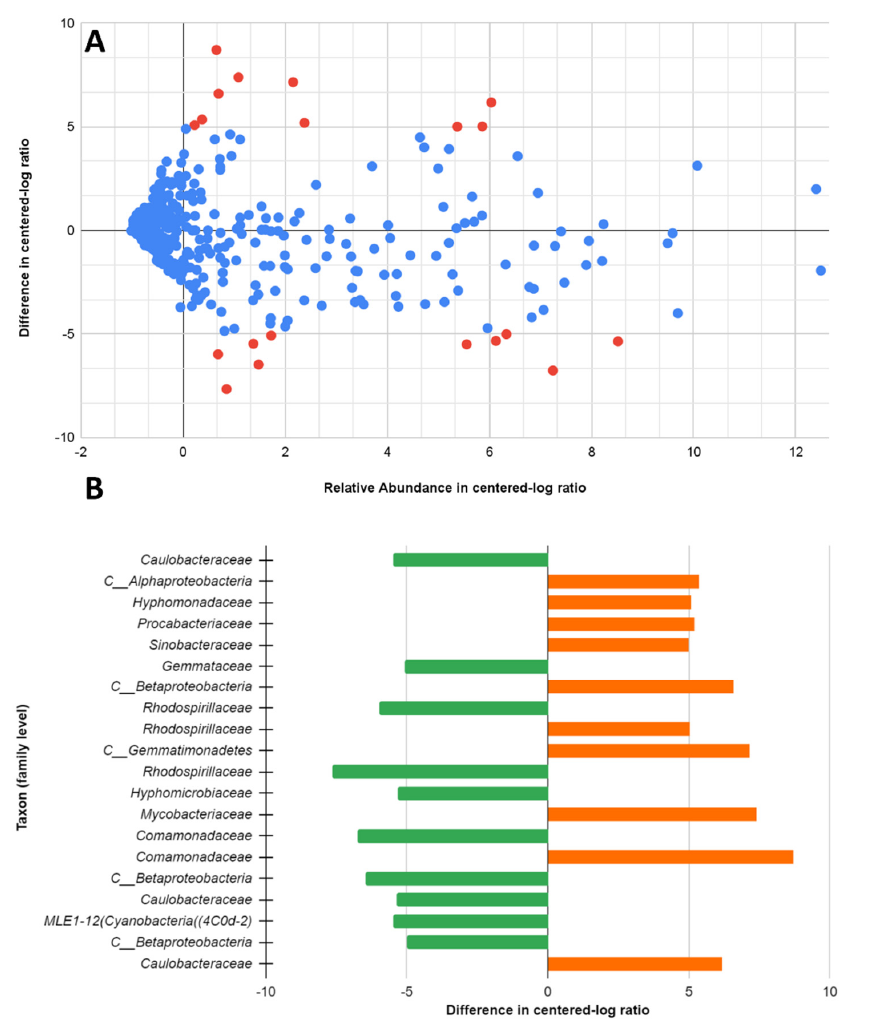
Figure 9. ALDEx2 differential abundance analysis between the 32 °C and 22 °C systems.: ( A ) Bland– Altman or MA plot between relative abundance and difference. (Significantly different taxa are plot- ted in red ); ( B ) significantly differentially abundant taxa classified at the family level. (32 °C: green, 22 °C: orange).